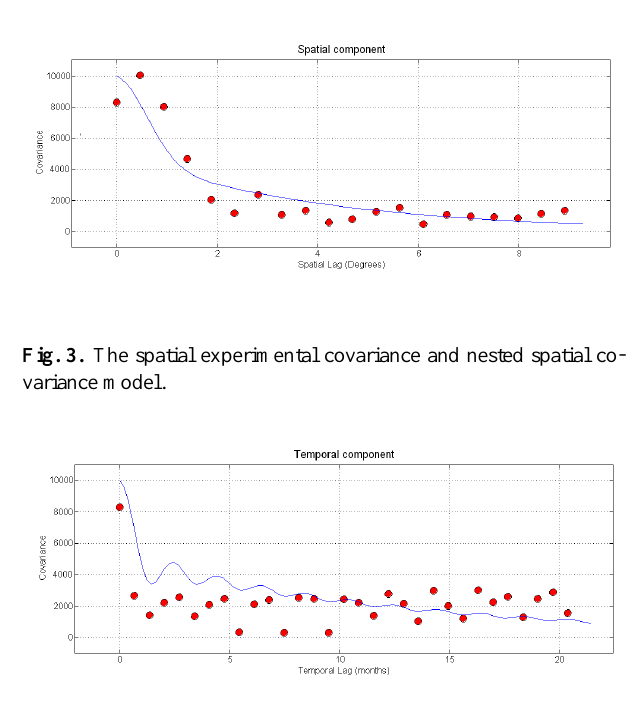
Fig. 4. The experimental temporal covariance and the nested co- variance model.